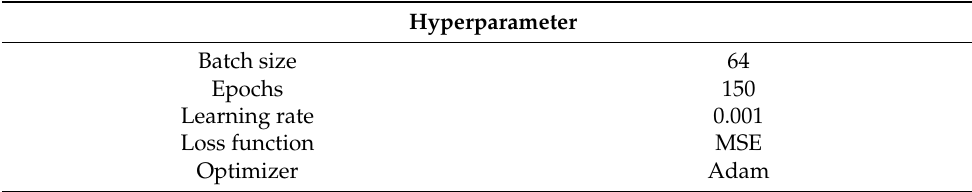
Table 2. Hyperparameter of